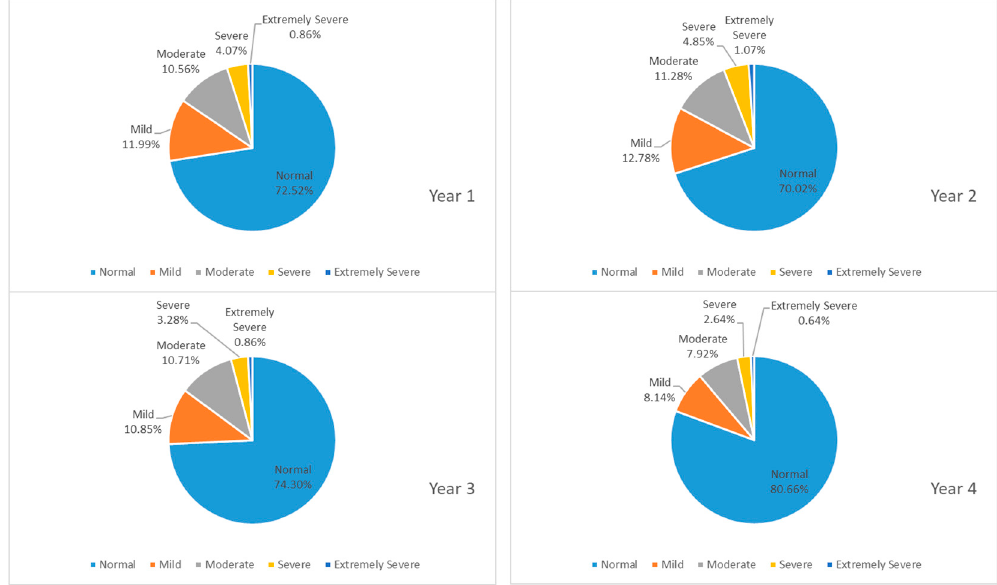
Figure 4. Proportion of participants whose answers on the DASS-21 indicated a normal, mild, moderate, severe or extremely severe amount of stress across years.